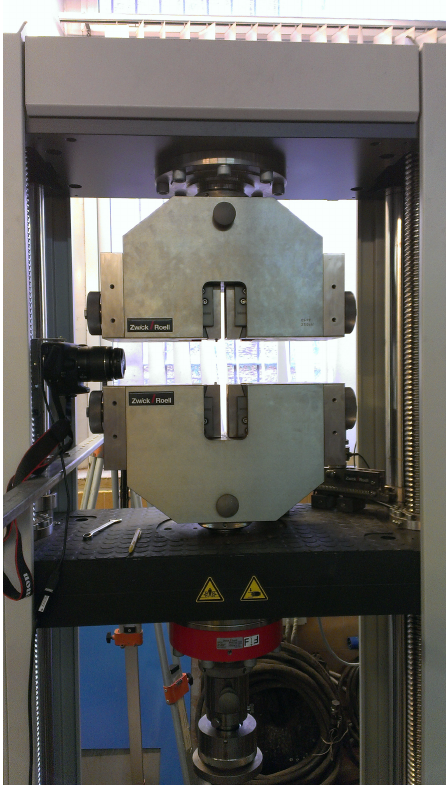
Figure 4. Experimental